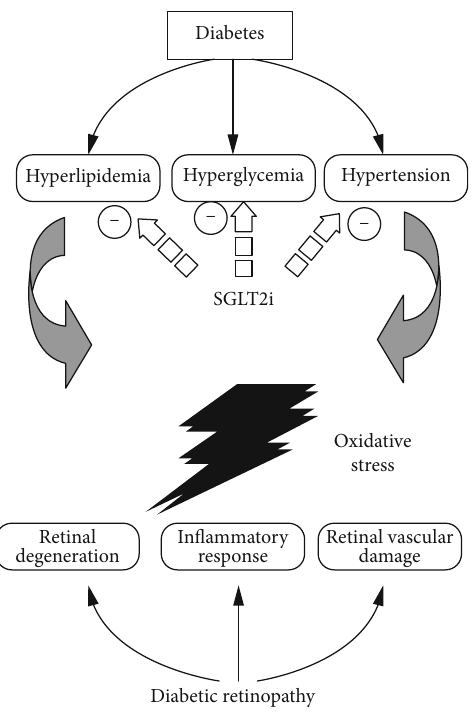
Figure 1: The proposed mechanism of SGLT2 inhibitor (SGLT2i) against diabetic retinopathy, in which SGLT2i improves hyperlipidemia, hyperglycemia, and